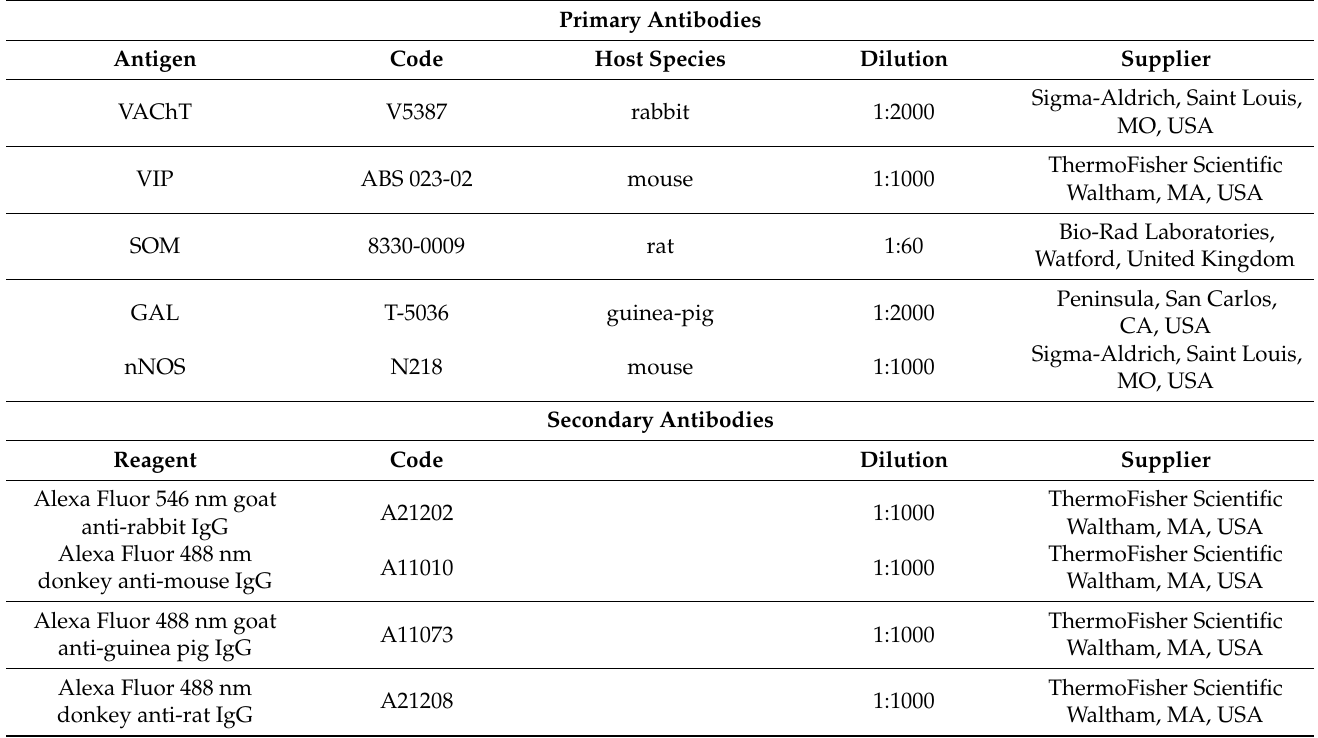
Table 1. Antibodies used for immunostaining